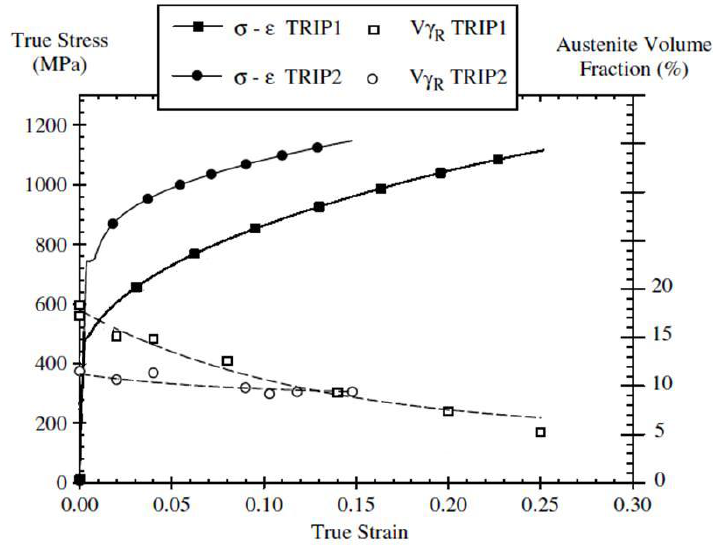
Figure 4. Two examples of the tensile response of two typical transformation induced plasticity (TRIP) aided steels and their corresponding austenite fraction evolution. Adapted from reference [47].